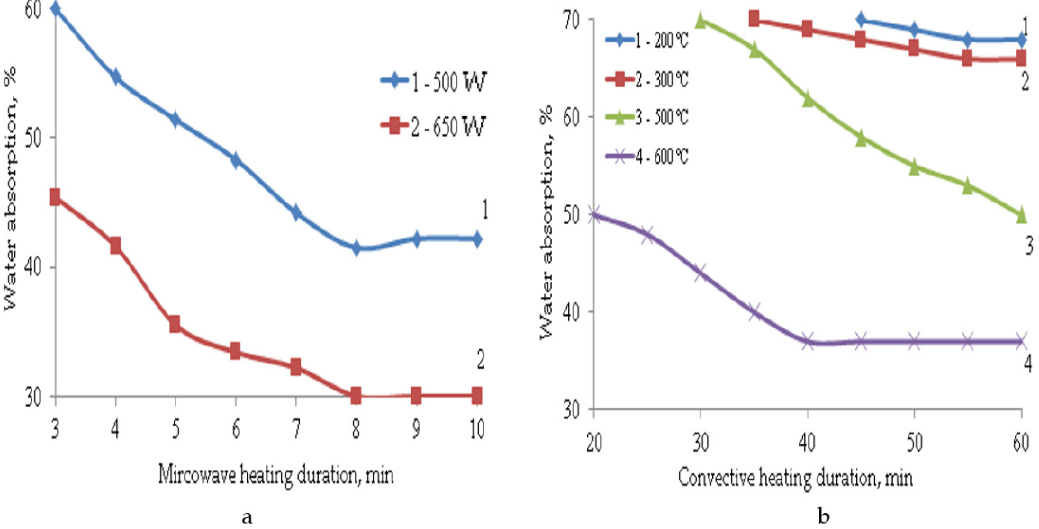
Figure 3. Dependence of water absorption on the parameters of microwave ( a ) and convective ( b ) heating.